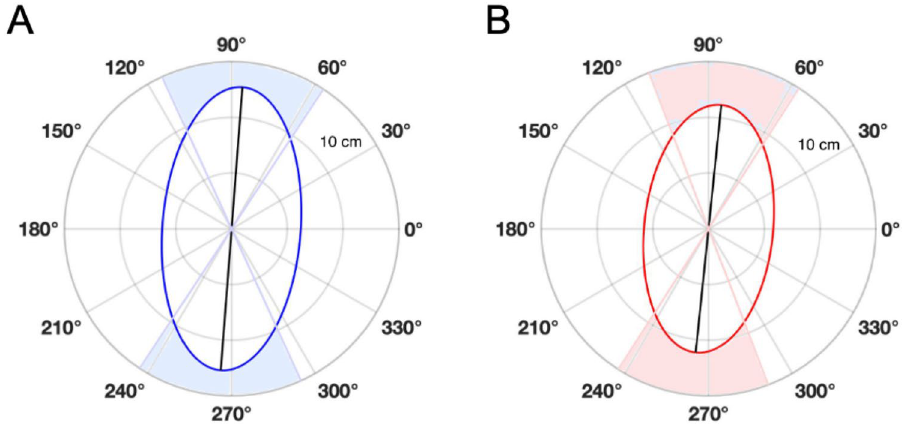
Figure 6. Mean direction of sway for before ( A ) vs after ( B ) manipulations. The black lines represent the main direction of sway (PC1) at the angle θ. The length of each black line is proportional to the mean quantity of movement expressed by the participants. Ellipses are a representation of the mean 95% area of COP displacement. Light blue (Before) and light red (After) shaded areas represent the angular deviations for each